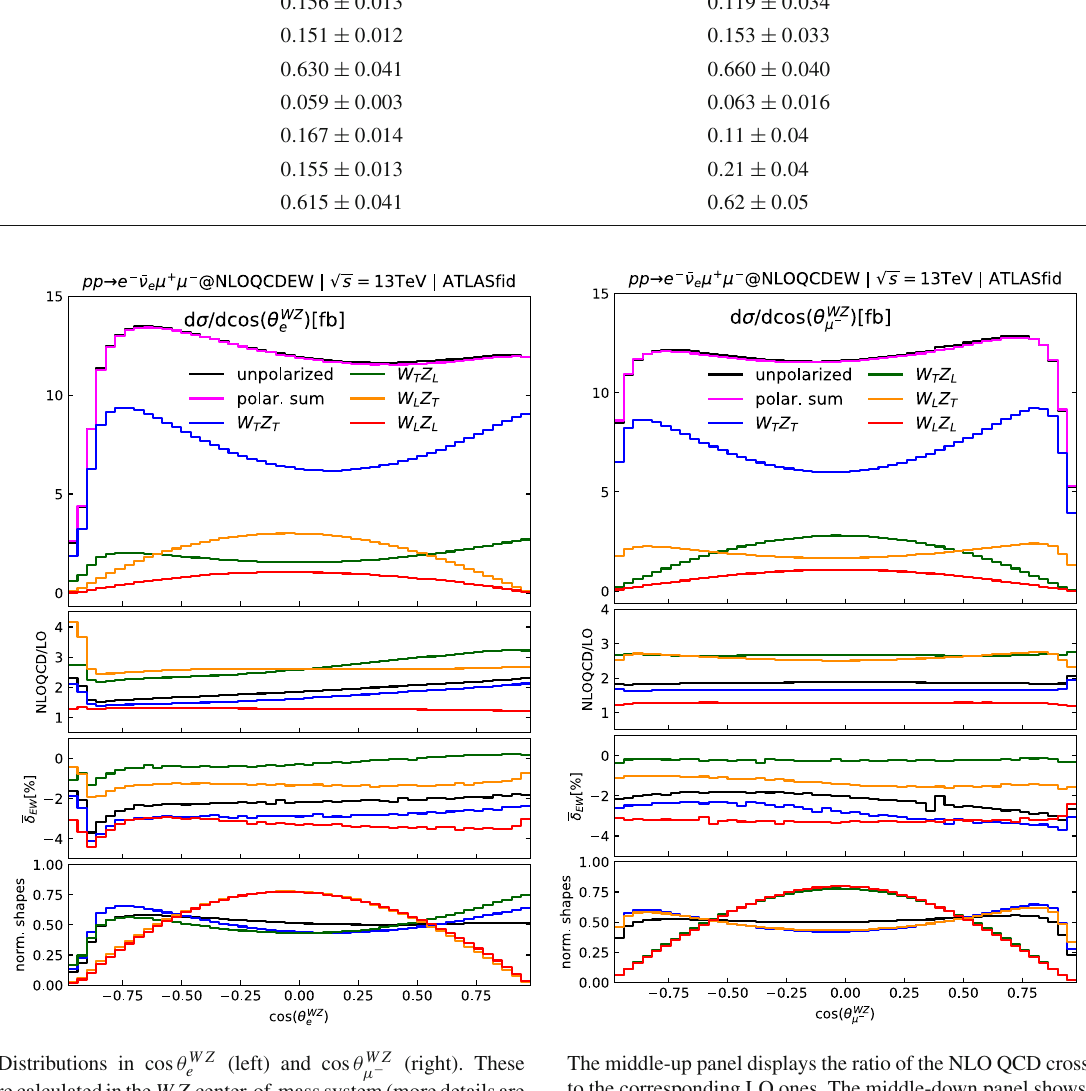
The middle-up panel displays the ratio of the NLO QCD cross sections to the corresponding LO ones. The middle-down panel shows ¯ δ EW , the EW corrections relative to the NLO QCD cross sections, in percent. In the bottom panel, the normalized shapes of the distributions are plotted to highlight differences in